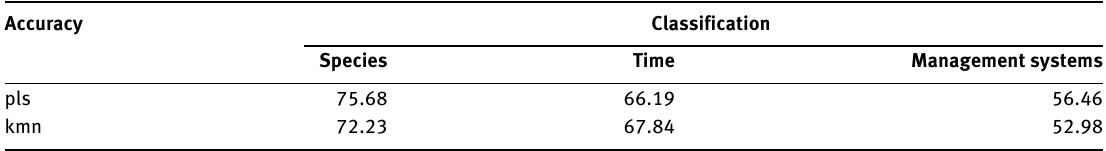
Table 1: Classification accuracy of predictive models PLS and knn according to plant species, time of cultivations and crop